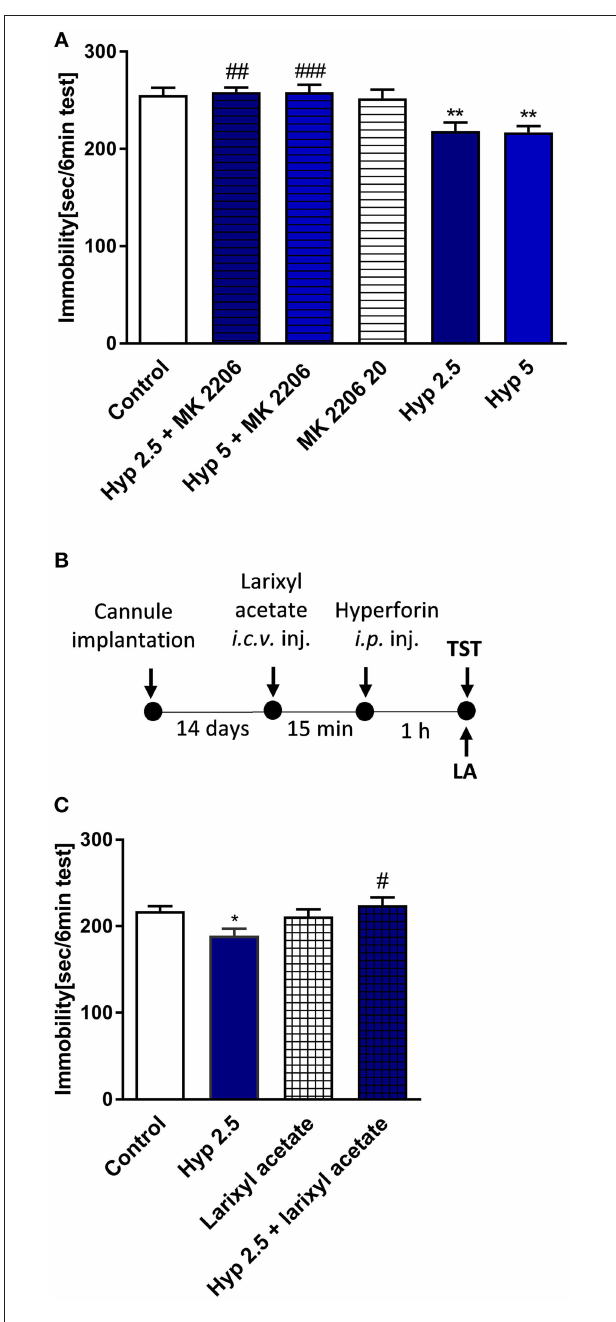
FIGURE 5 | The effect of pretreatment with Ca 2 + -dependent process modulators on hyperforin activity in the TST in mice (A) MK-2206 (Akt1/2/3 kinase inhibitor: 20 mg/kg; i.p. ) was administered 15min before hyperforin (2.5 and 5 mg/kg; i.p. ). TST was carried out 60min after hyperforin treatment. ** p < 0.01 vs. control, ## p < 0.01 vs. hyperforin 2.5, ### p < 0.001 vs. hyperforin 5, n = 6–8; [ F (5,34) = 7.144; p = 0.001]. (B) Experimental schedule of drug treatments and behavioral tests. (C) Larixyl acetate (TRPC6 antagonist: 10 nM/2 µ L; i.c.v. ) was injected 15min before hyperforin (2.5 mg/kg; i.p. ) and 60min after hyperforin treatment the TST was carried out * p < 0.05 vs. control, # p < 0.05 vs. hyperforin, n = 9–10; [ F (3,35) = 3.892; p = 0.0168]. All data was analyzed by one-way ANOVA and Newman-Keuls multiple comparisons test. All values are expressed as mean ± S.E.M.